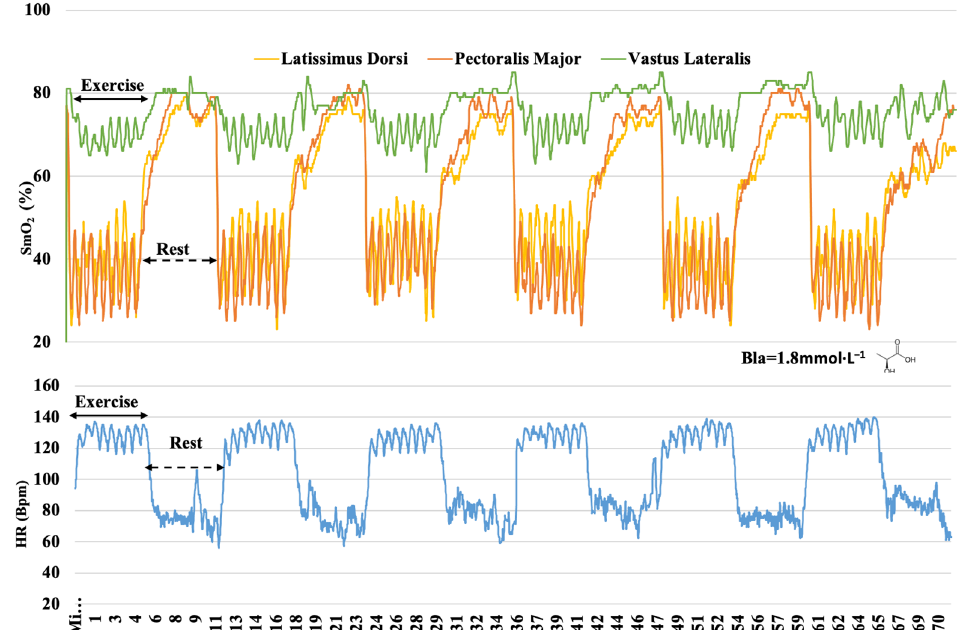
Figure 6. Muscle oxygen saturation (SmO 2 ) kinetics in latissimus dorsi, pectoralis major, and vastus lateralis and heart rate (HR) response during SIT protocol; blood lactate (Bla) concentration 3 min after the end of the protocol.